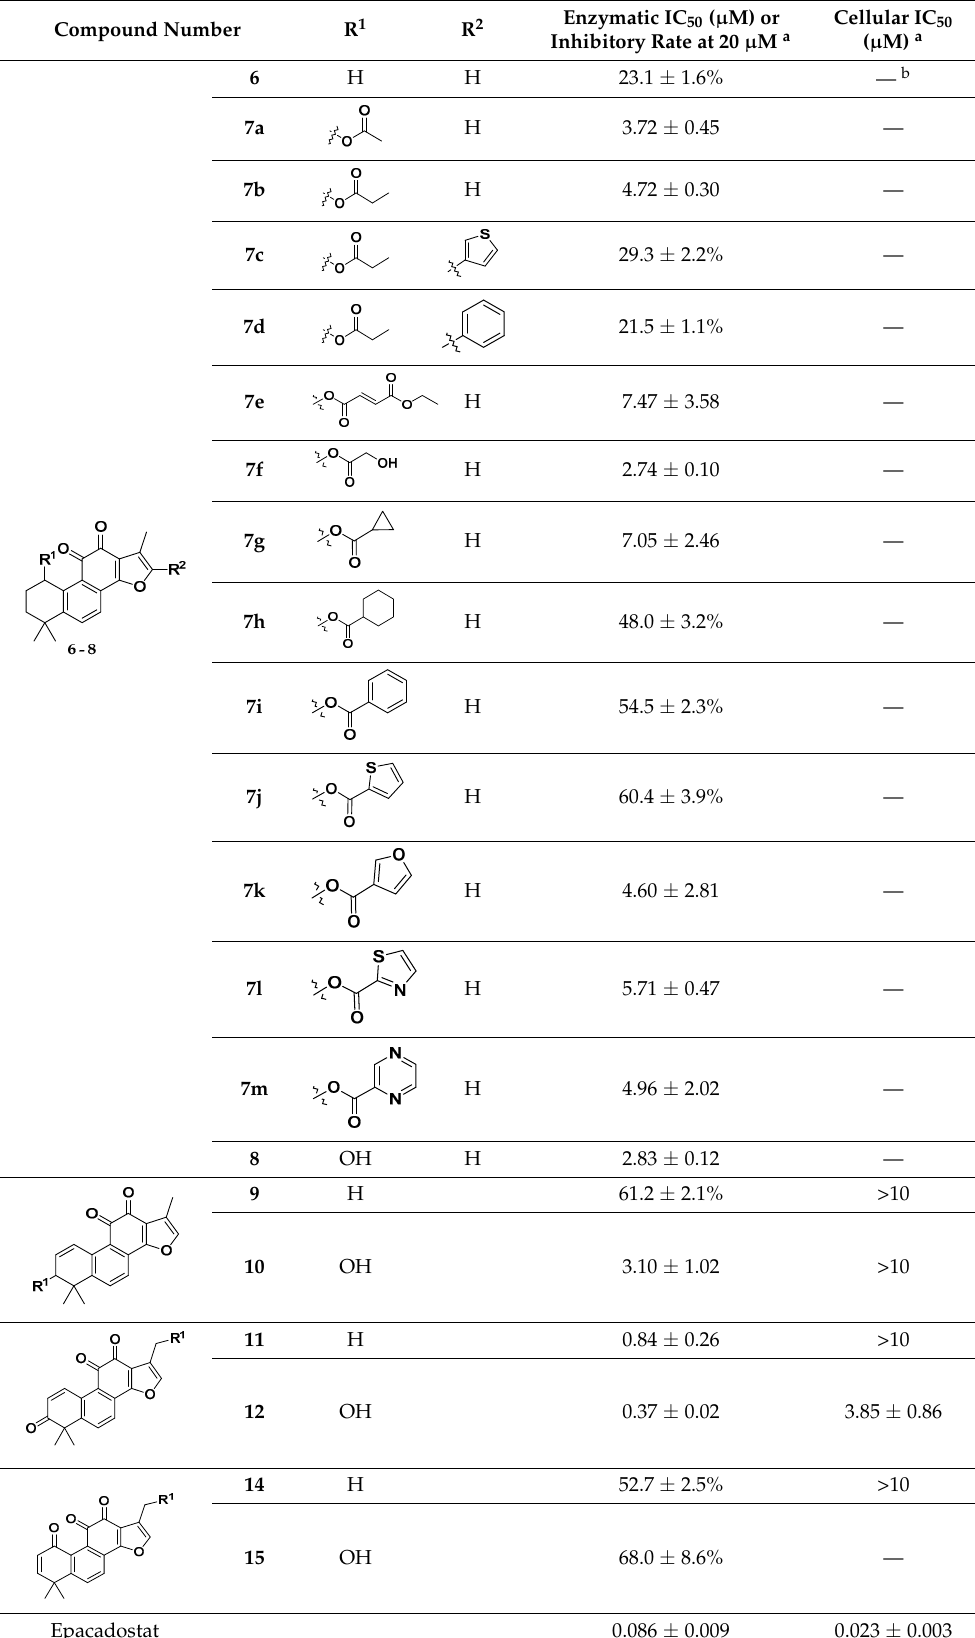
Table 1. Structures of acyloxy derivatives 7a – m.